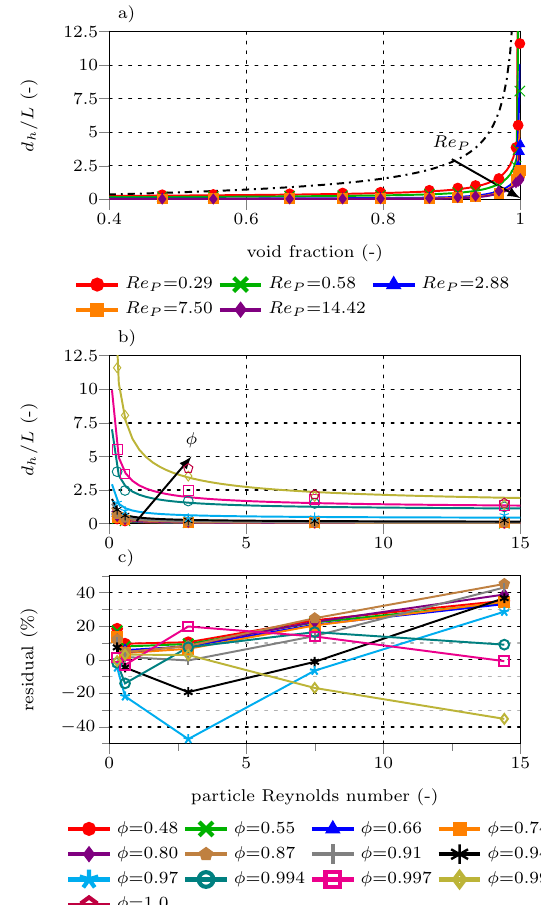
Figure 11. Comparison of d h / L correlation given by Equation (19) ( ) with simulation data ( ) and d h = 2/3 φ / ( 1 φ ) 2/3 [61] ( ) versus the cluster void fraction ( a ) and particle Reynolds number − ( b ). The relative errors of Equation (19) compared to CFD-simulated data is presented in ( c